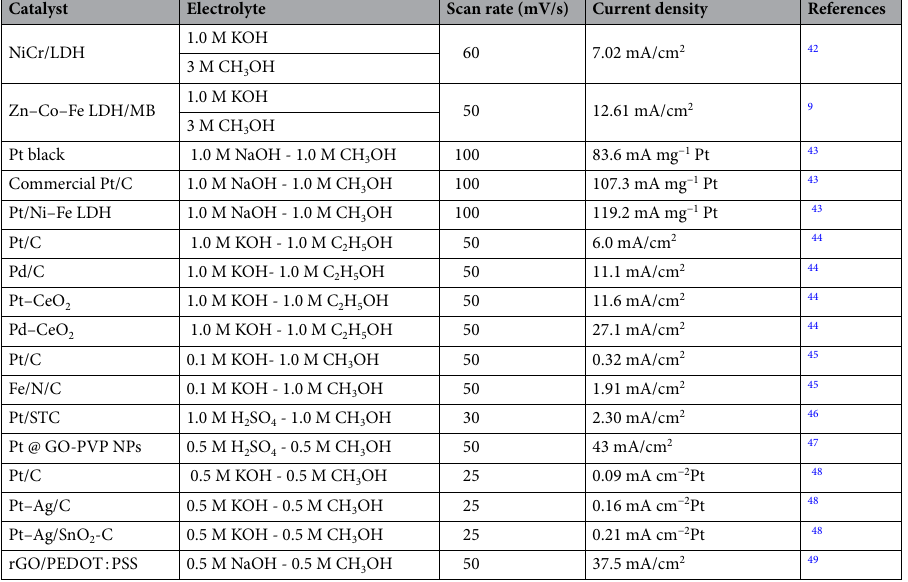
Catalyst Electrolyte Scan rate (mV/s) Current